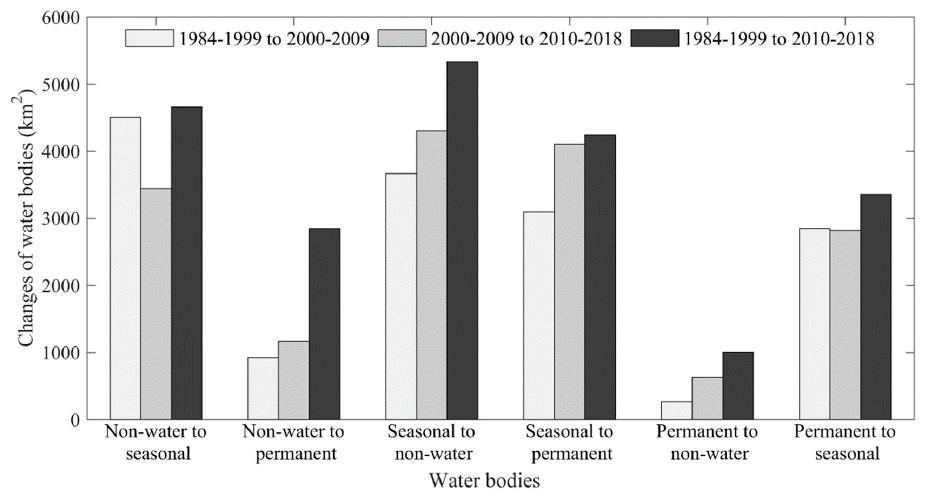
Figure 9. The conversion of open-surface water bodies in the YRB.